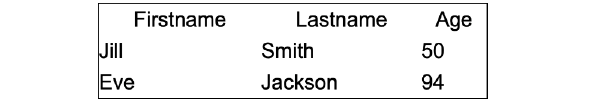
Figure 21. Visualization of the HTML code generated by the getMainObjects function returning a table built using the tag